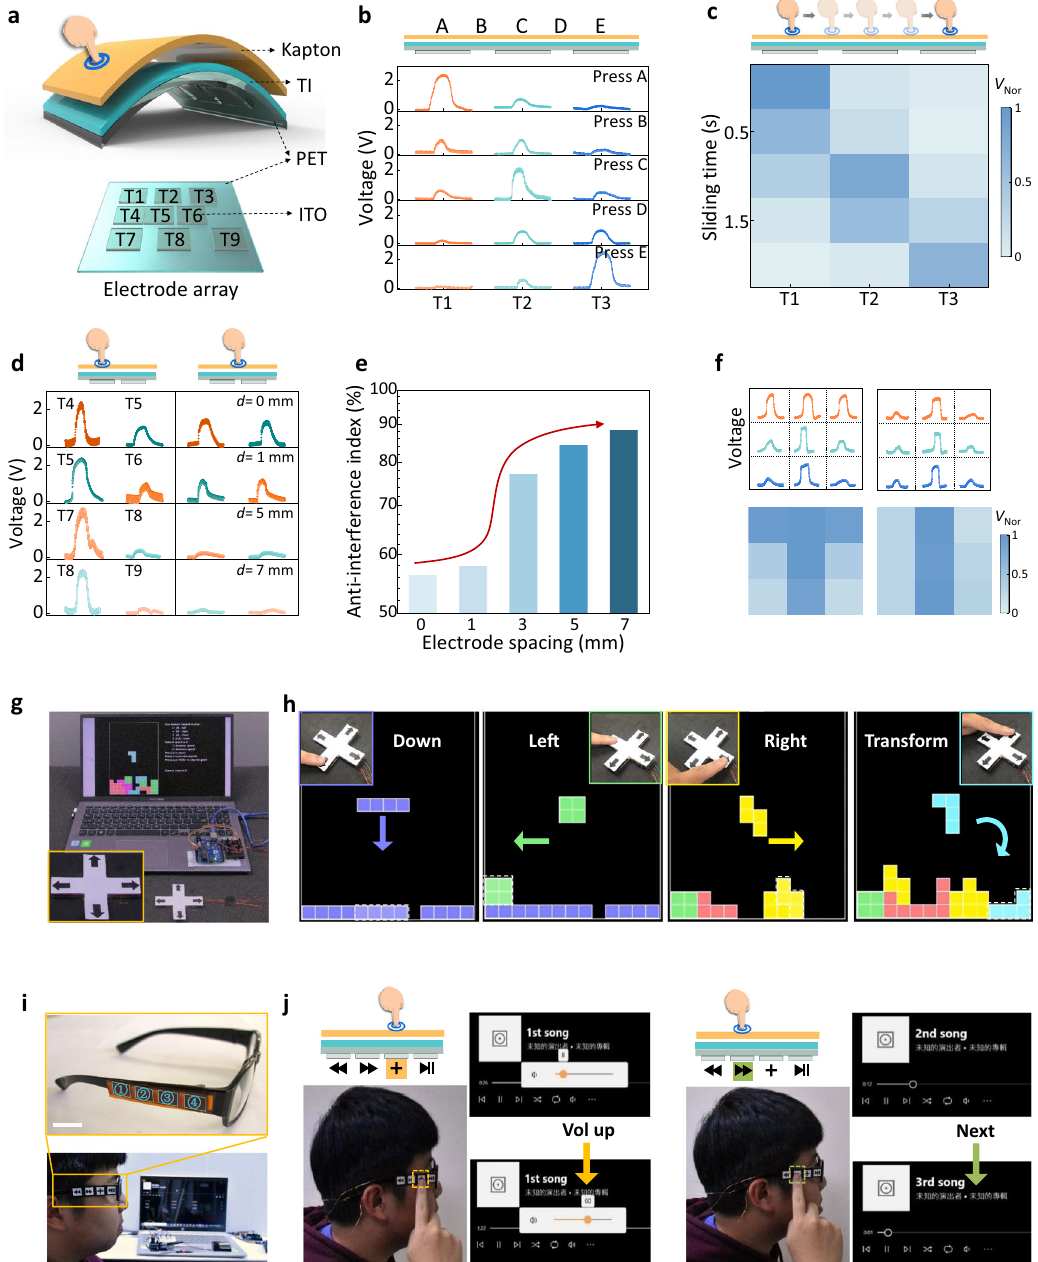
Fig. 6 TI-TENG self-powered sensors and system-level applications. a Structural schematics of the designed TI-TENG sensor array with various spacings. The bottom view shows the relative distribution of nine ITO electrodes, corresponding to nine independent TENGs (numbering from T1 to T9). b Output voltage signals of TI – T3 by touching different sites. The top panel illustrates the corresponding pressing sites of A – E. c Output voltage signals mapped in electrode positions and measurement time when sliding across the surface of TI fi lm from T1 to T3 (sliding speed: 13 mm s − 1 ). V Nor means the normalized voltage signals. d Output signals of T4 – T9 by pressing on the top of the electrodes of T4, T5, T7, T8 (left panel), and middle sites (right panel). For a fair comparison, the tapping sites highlighted at the top panel were operated with a uniform contact force and area. e Plots of the statistical anti-interference index of TI-TENG sensory system depending on different spacings from panel (d), which shows the anti-interference abilities of tactile sensors at each spacing to improve the system-level design. Note that the index was extracted from the ratio of ( V 0 − V )/ V 0 , where V and V 0 represent the measured voltage value for each cell with possible disturbance and without disturbance, respectively. A curve arrow is used to guide eyes. f Recorded output voltage curves and normalized maps of T1 – T9 when touching with different objects of letter T and I. g Image of a game controller integrated with four TI-TENG sensors and zoom-in sensory system (inset). h Images of various demonstrations of TI-TENG sensors-enabled operating instructions, including Down, Left, Right, and Transform. i Images of a pair of smart glasses-enabled wireless music players. The upper panel illustrates four integrated TI-TENG sensors on the side bracket. TENG cells with numbers 1 – 4 represent directions of Last, Next, Vol up (voice up), and Play/Stop, respectively. j Demonstration of operating the Vol up and Next instructions via triggering self-powered TI-TENG sensors. Scale bar in ( g ) and ( i ): 2 cm. Source data are provided as a Source Data fi